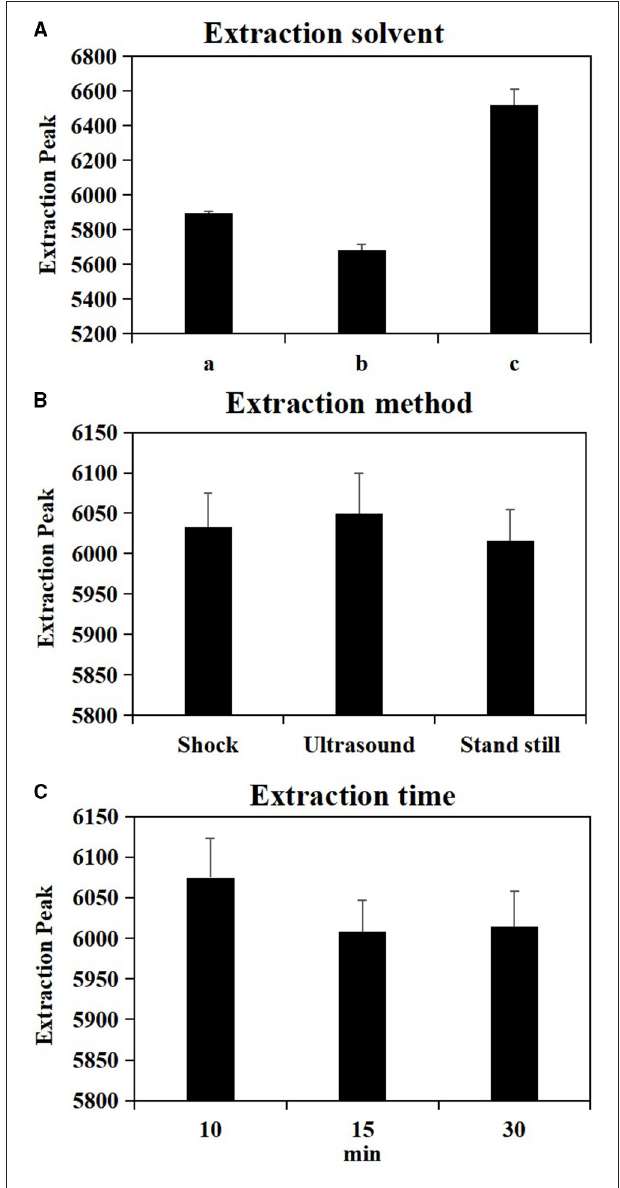
FIGURE 1 | Effect of single factor extraction solvent (A) , extraction method (B) and extraction time (C) on metabolite extraction. a = 80% Acetonitrile (0.1% Formic acid), b = 80% Acetonitrile (0.1% Acetic acid), c = Methanol: Acetonitrile: H 2 O (2:2:1,